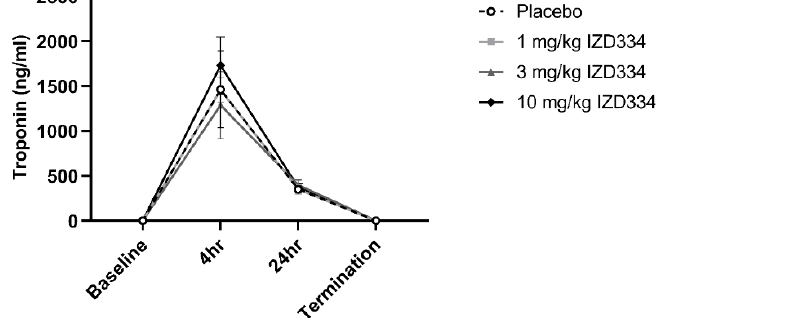
Figure 7. Cardiac troponin levels. Circulating levels of troponin at baseline and after reperfusion (4 h, 24 h, and prior to termination). Data are presented as mean ± SEM ( p -values following mixed models testing).